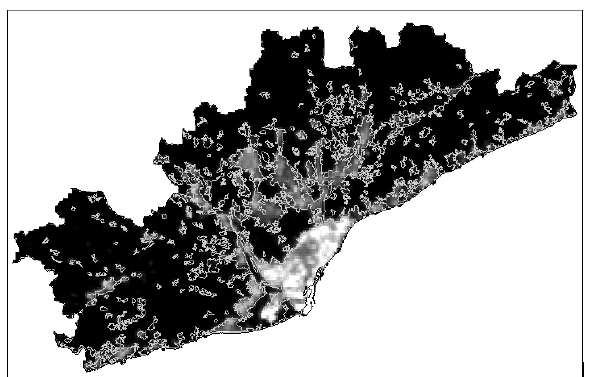
Figure 7. SNPP-VIIRS